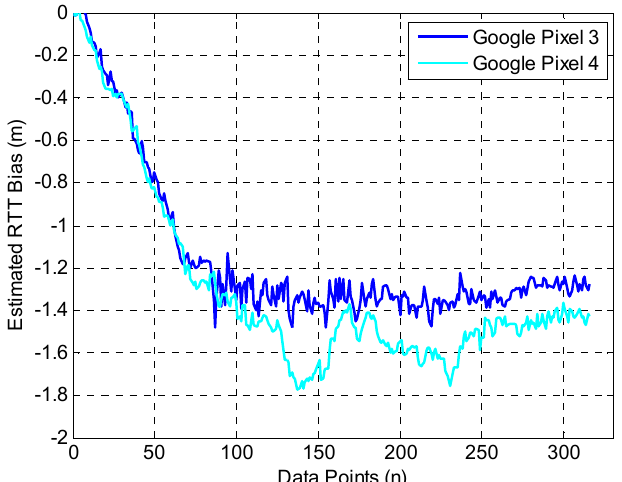
Figure 10. Performance of RTT Bias Calibration.